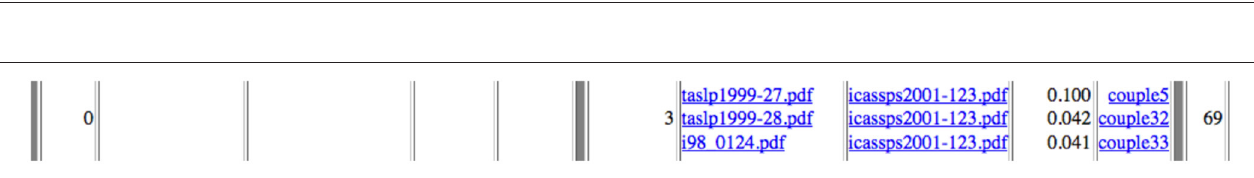
The program produces also global results in the form of matrices ( Tables 11 , 12 ) for each of the four categories (Self-reuse, Self-Plagiarism, Reuse, and Plagiarism) displaying the number of papers that are similar in each couple of the 34 sources,